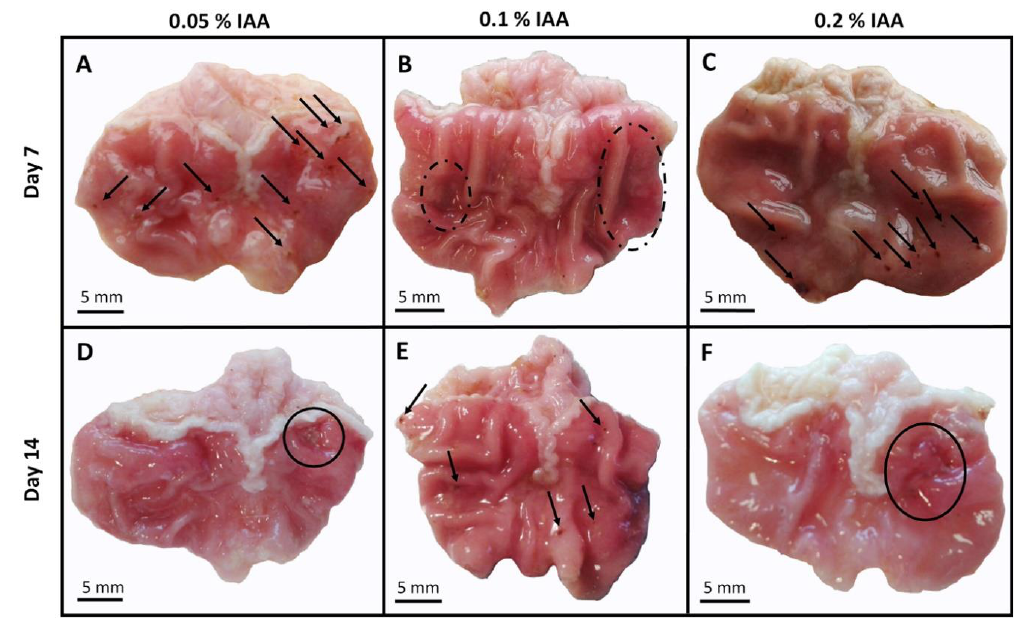
Figure 1. Macroscopic pictures of iodoacetamide-induced (IAA) gastric mucosal inflammation. Representative photos of gastric mucosa of Wistar rats receiving ( A ) 0.05%, ( B ) 0.1%, ( C ) 0.2% IAA for 7 and ( D – F ) for 14 days, respectively. After 7 days, diffuse hyperemia (dashed circles) and several superficial mucosal erosions (black arrows) developed, while by the end of the 14-day-long protocol, chronic ulcers were also observable in some animals (circles on panel ( D , F